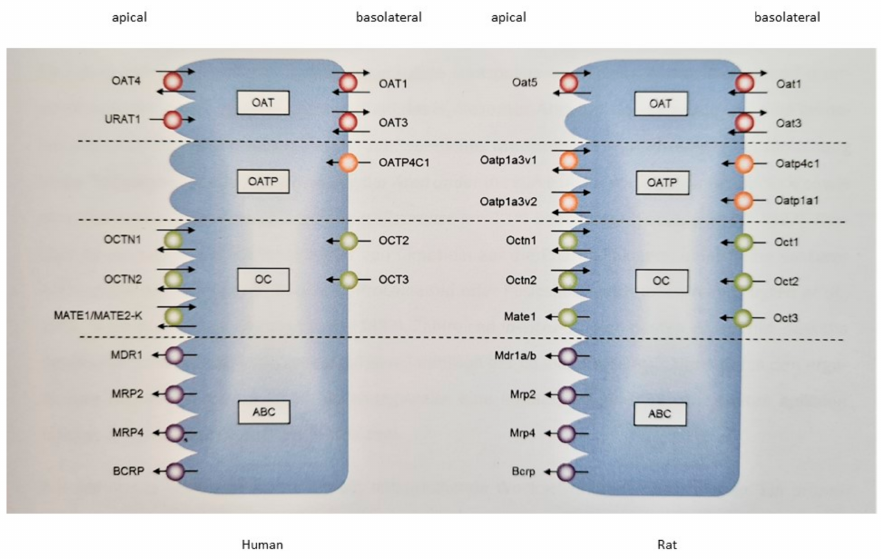
Figure 1. Proteins relevant for renal drug transport in humans and rats. OAT/Oat: Organic anion transporter; URAT: Urate transporter; OATP/Oatp: Organic anion transporting polypeptide; OC: Organic cation; OCTN/Octn: Organic cation transporter, novel; MATE/Mate: Multidrug and toxin extrusion protein; ABC: ATP-binding cassette; MDR/Mdr: Multidrug resistance; MRP/Mrp: Multidrug resistance-related protein; BCRP/Bcrp: Breast cancer resistance